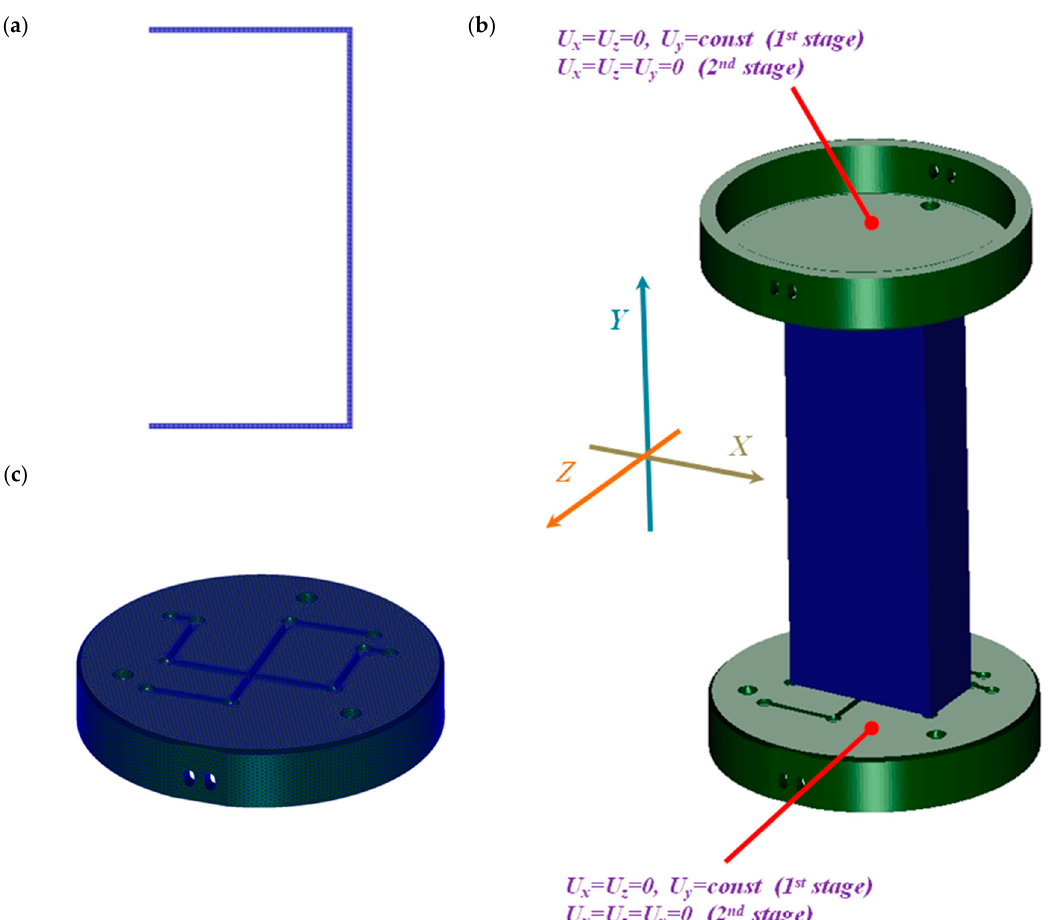
Figure 3. The finite element (FE) model of the column ( a ) and the discrete model of the plates ( b ) and the whole model with the boundary conditions ( c ).